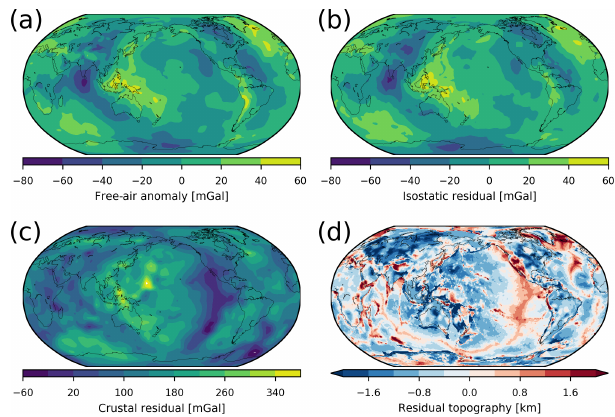
Figure 1. Input data for the inversions. (a) Free-air anomaly at a measurement height of 225km. (b) Isostatic residual gravity anomaly at 225km height. This is obtained by correcting for the presence of topography and isostatic compensation masses. (c) Crustal residual gravity anomaly at 225km height obtained by removing the gravity effect of the crustal model from Szwillus et al. (2019). (d) Residual topography after removing the isostatic contri- bution of the crustal model from Szwillus et al. (2019).